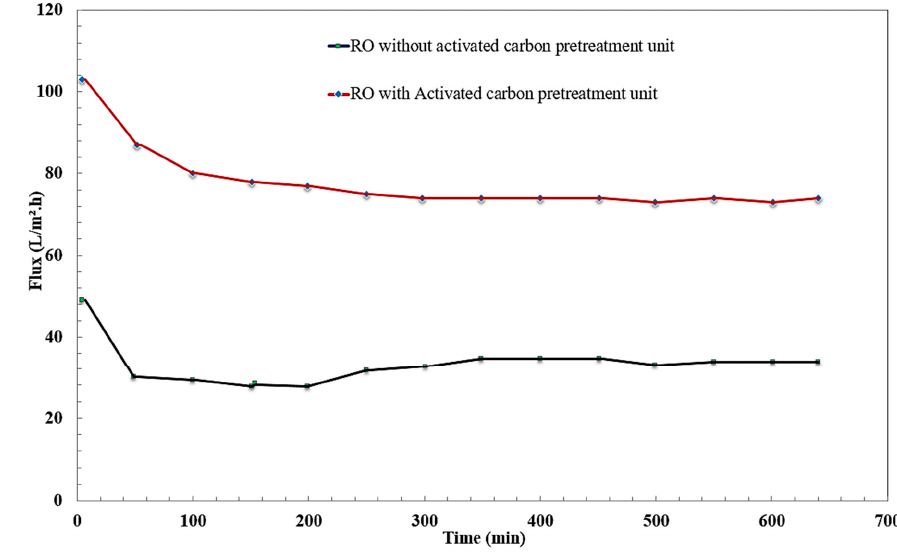
Figure 10. Effect of time separation on flux. Figure 10. E ff ect of time separation on